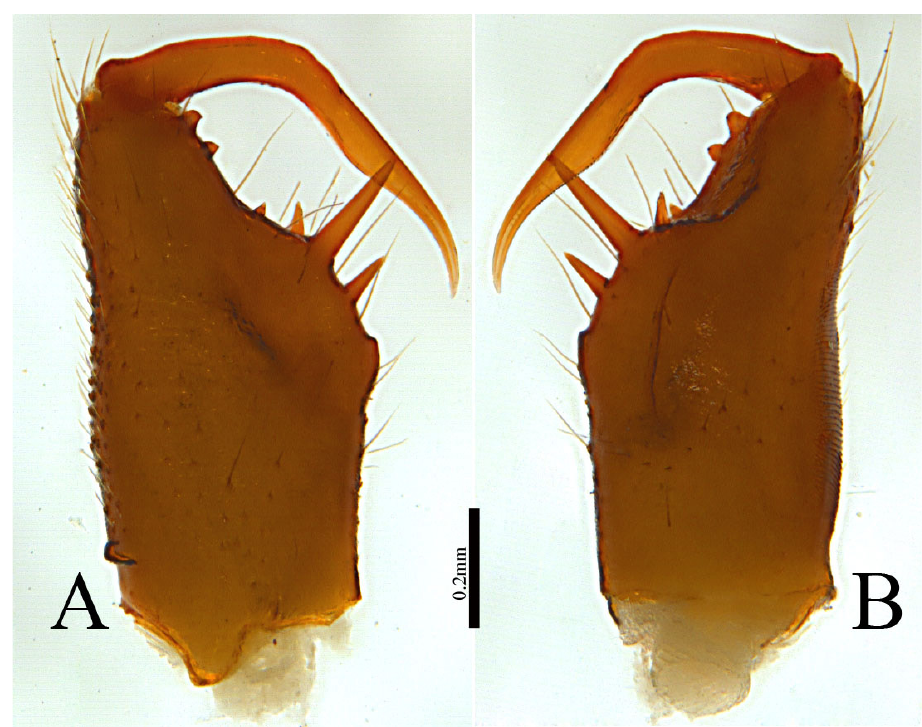
Fig. 2. Acroterius absentus gen. et sp. nov., ♂, holotype (HNU-Tang031027). A . Chelicera, dorsal view. B . Chelicera, ventral view.